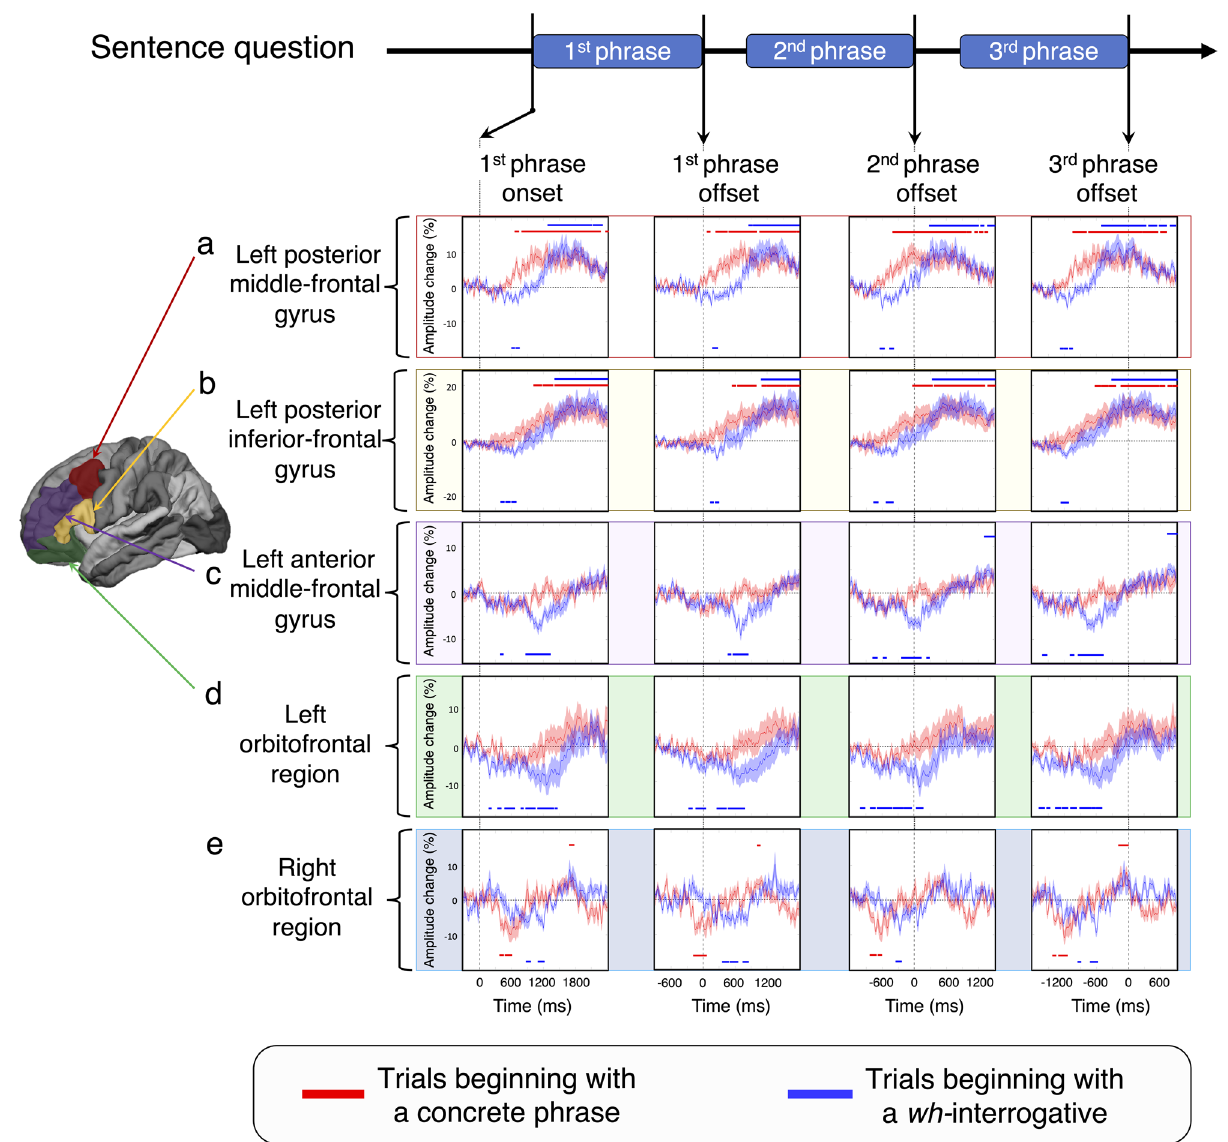
Figure 4. The dynamics of high-gamma modulations during sentence comprehension task. ( a )-( d ) High- gamma modulations in the left hemisphere. ( e ) High-gamma modulations in the right hemisphere. The mean percent change in high-gamma activity is presented with a standard error bar. Red plots and bars: Trials beginning with a concrete phrase. Blue plots and bars: Trials beginning with a wh -interrogative. Upper horizontal bars: Significant amplitude augmentation lasting at least 60 ms (including at least four 65 Hz-band oscillations). Lower horizontal bars: Significant amplitude suppression lasting at least 60 ms. First column: Time-locked to the 1st phrase onset (i.e., sentence onset). Second column: Time-locked to the 1st phrase offset. Third column: Time-locked to the 2nd phrase offset. Fourth column: Time-locked to the 3rd phrase offset (i.e., sentence offset). ( a ) and ( b ) The left posterior middle- and inferior-frontal gyri (MFG and IFG) showed a rising of high-gamma activity around the 1st phrase offset during trials beginning with a concrete phrase. These regions showed high-gamma suppression maximally around the 1st phrase offset during trials beginning with a wh- interrogative. ( c ) and ( d ) The left anterior MFG and orbitofrontal regions showed high-gamma suppression maximally around the 2nd phrase offset during trials beginning with a wh- interrogative. ( e ) The right orbitofrontal region showed high-gamma suppression maximally before the 1st phrase offset during trials beginning with a concrete